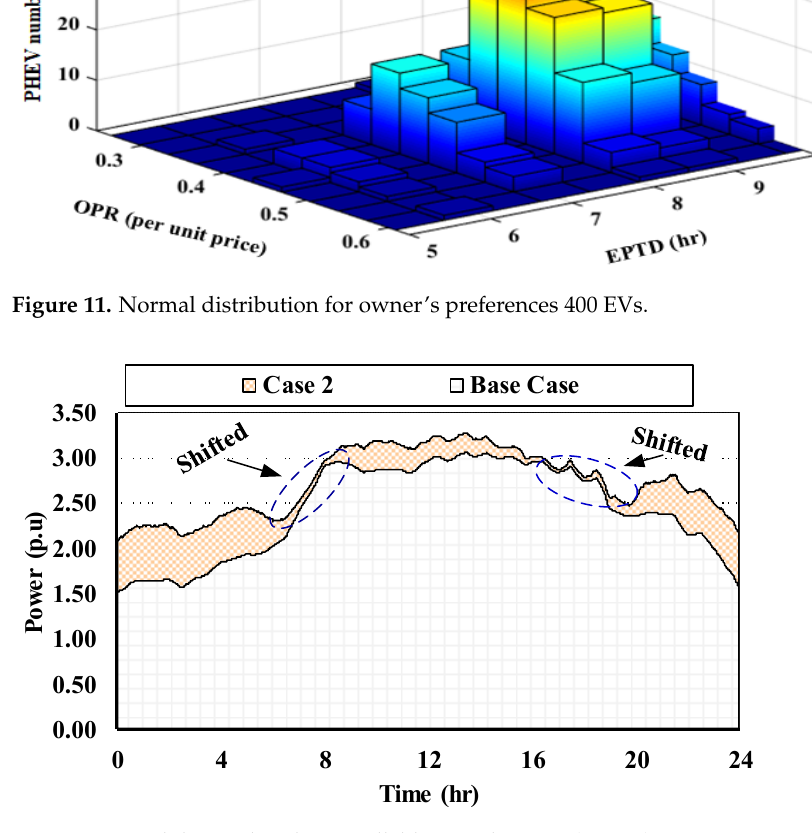
Figure 12. Total demand with controllable EVs charging (Case 2).